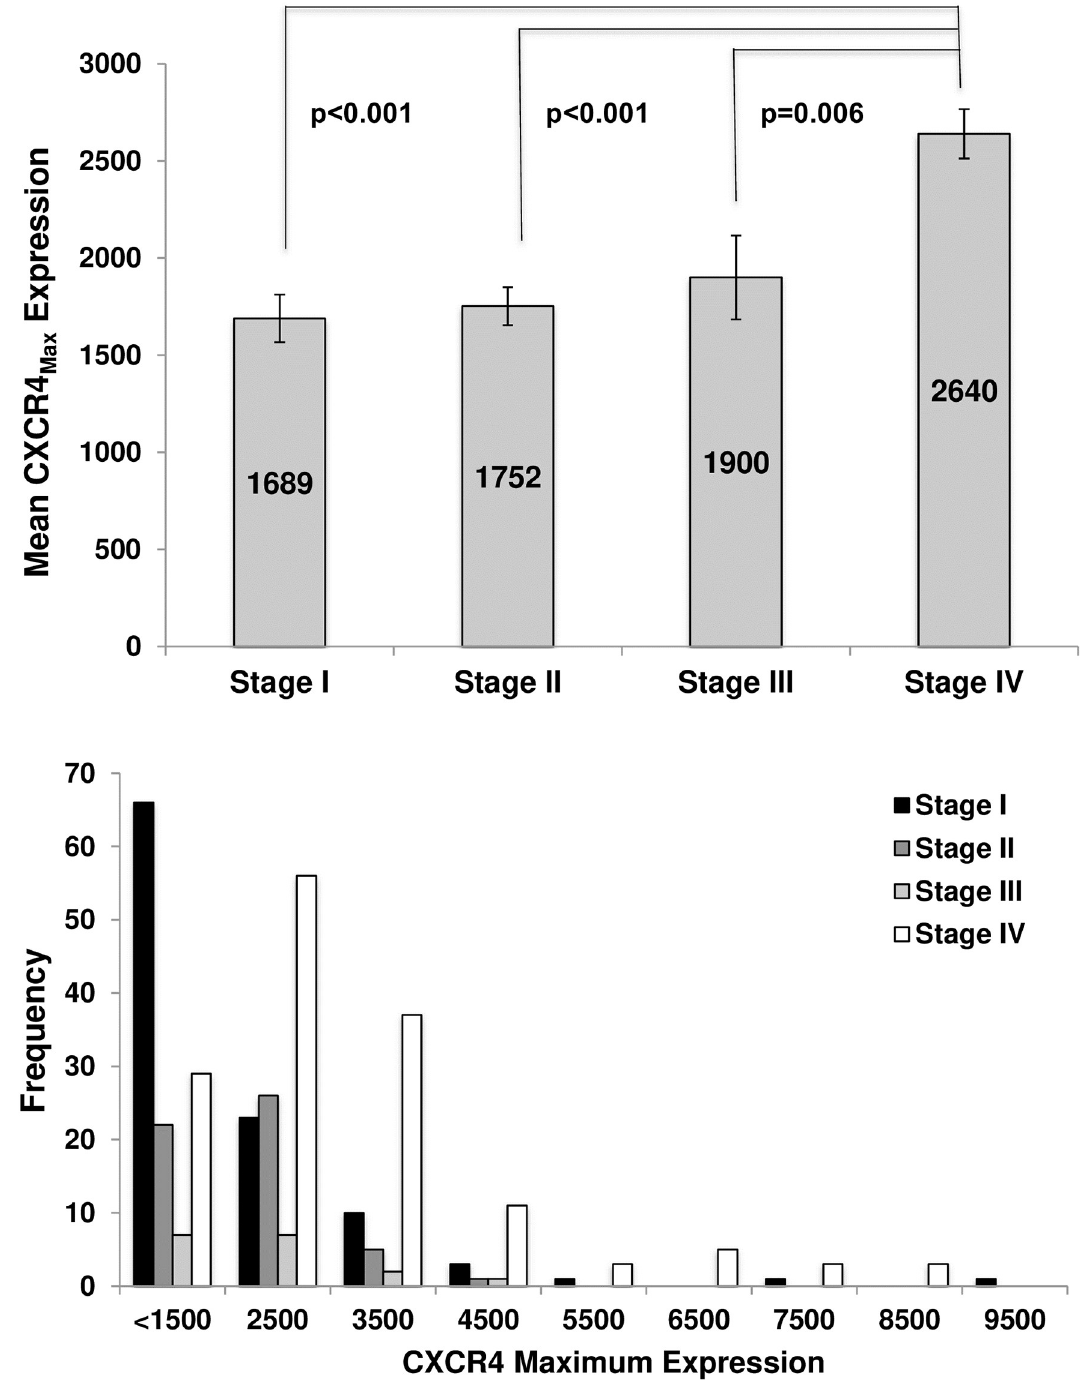
Fig 2. CXCR4 expression is lower in early stage compared to late stage NSCLC patients. Mean CXCR4 Max expression increased with stage progression, with higher CXCR4 expression in stage IV NSCLC patients (top panel); error bars represent standard error of the mean. Maximum CXCR4 expression levels > 2500 were less frequent in early stage lung cancer patients compared to late stage patients (bottom panel).